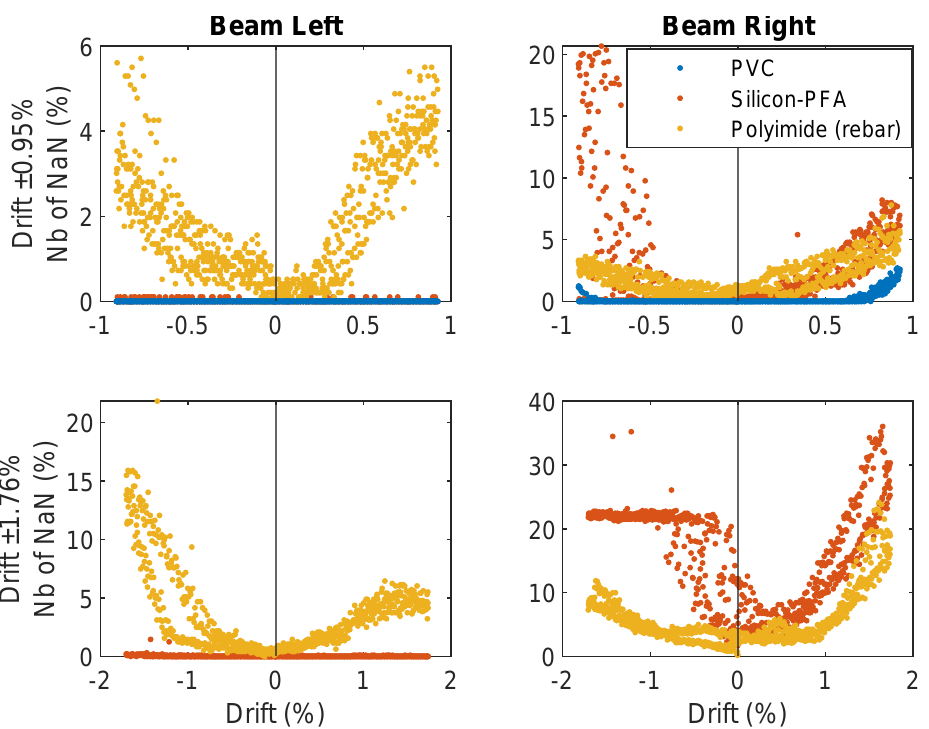
Figure 13. Relation between percentage of NaN and drift ratio for different fiber-optic cables under two different loading steps.